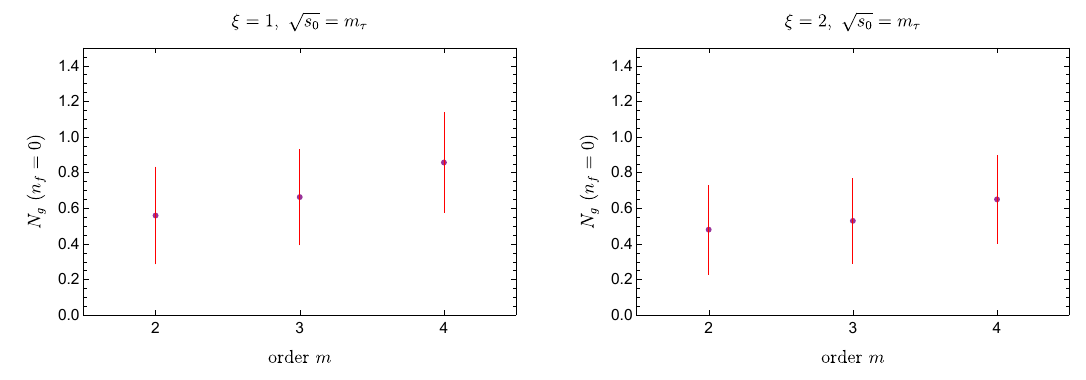
Figure 4 . Results for N g at O ( α 2 , 3 , 4 ) using the optimal subtraction approach for ξ = 1 (left panel) s and ξ = 2 (right panel) for the n f = 0 flavor